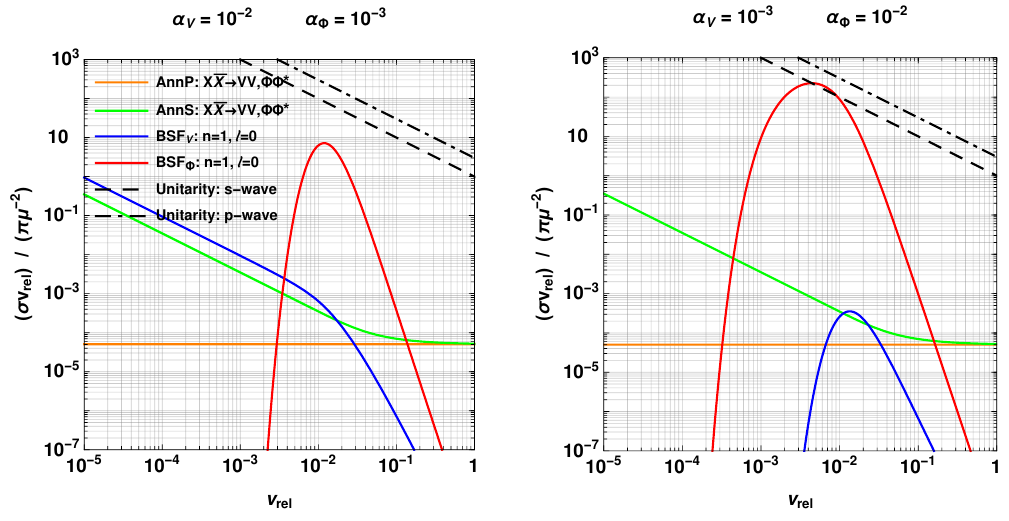
Figure 11 . The BSF and annihilation velocity-weighted cross-sections that we consider in the computation of the DM freeze-out, vs. v rel . All cross-sections have been normalised to (cid:25)=(cid:22) 2 , with (cid:22) = m = 2 being the reduced mass of the interacting particles. Also shown, the unitarity limits on X s -wave and p -wave inelastic processes, which have to be respected by BSF for capture into the ground state.